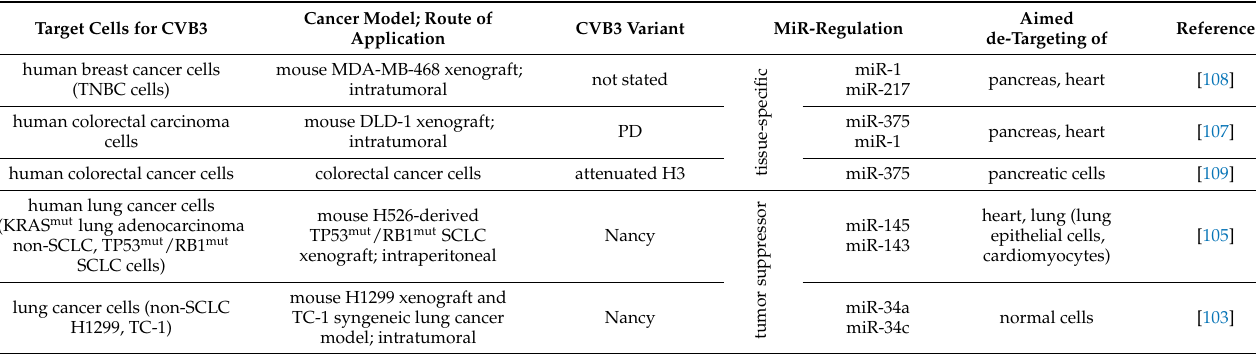
Figure 5. Oncolytic CVB3 strains-origin, oncolytic efficacy and side effects. The Nancy strain of CVB3 was isolated in New Haven, CT, USA in 1948 from a 3-year-old patient called Nancy [99]. The Nancy strain induces pancreatitis and myocarditis and has been shown to be lytic in colorectal and lung cancer [20,92,103–105]. The PD variant arose after 13 passages of persistent CVB3 Nancy p strain in human fibroblasts (HuFi) [102]. The PD strain is lytic in HuFi and colorectal carcinoma [92,102]. The strain 31-1-93 was isolated after passaging the PD strain through the murine heart [106]. It shows oncolytic activity in colorectal carcinoma and induces severe pancreatitis and myocarditis in mice [77,92]. CV-B3/2035A strain was isolated in Xiamen, PRC in 2008 from a patient’s throat swab, who presented with light symptoms of hand, foot and mouse disease. The CV-B3/2035A strain has oncolytic potential in endometrial carcinoma [91]. The strain H3 is a cardiotropic strain of CVB3 Nancy, which has oncolytic activity in colorectal cancer but induces severe pancreatitis and myocarditis [74,100,107]. Table 1. Oncolytic CVB3 virotherapy for cancer